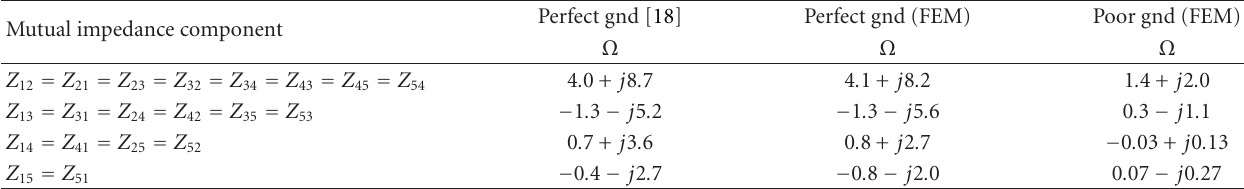
Table 2: Mutual impedance for five element monopole arrays over perfect and poor ground at 2.4 GHz.